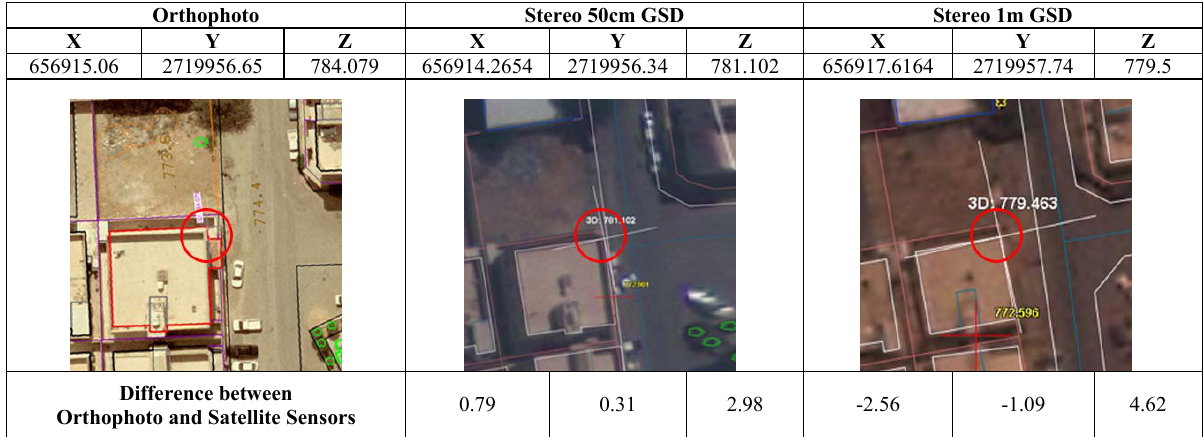
Table 1f. showing capturing of building corner based on different resolutions of